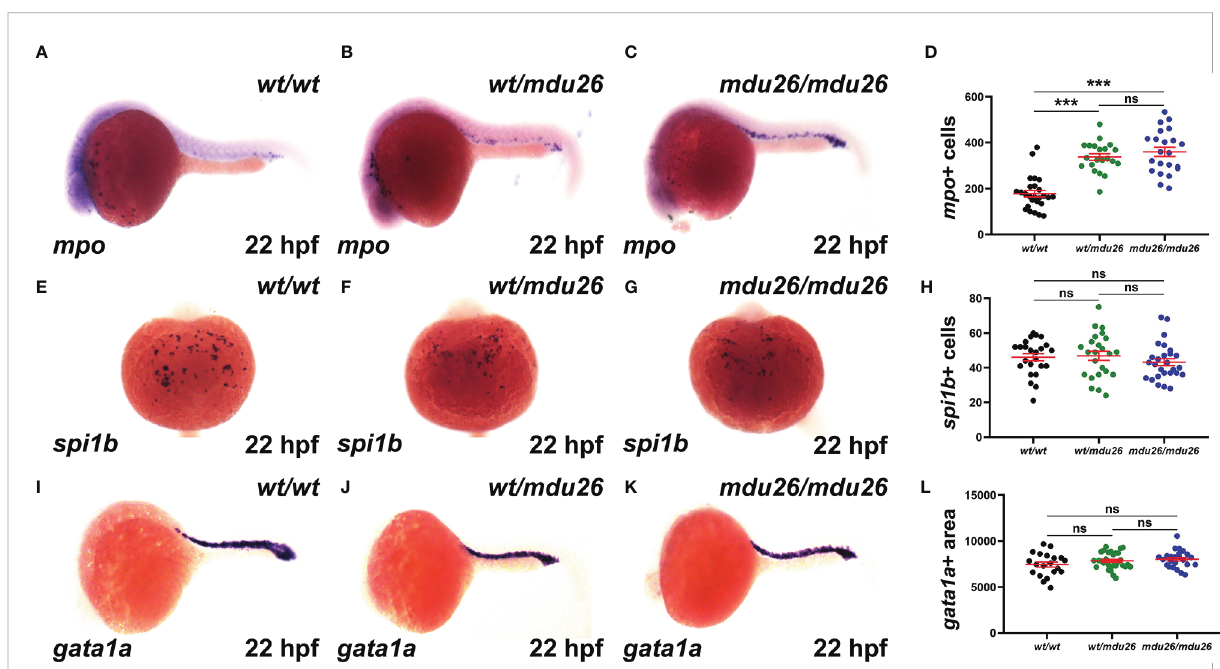
FIGURE 2 Effect of G-CSFR truncation mutation on primitive hematopoiesis. Wild-type ( wt/wt ), heterozygous ( wt/mdu26 ) and homozygous ( mdu26/ mdu26 ) mutant csf3r embryos were subjected to WISH at 22 hpf with mpo (A – C) , spi1b (E – G) and gata1a (I – K) , with representative images shown. Individual embryos were assessed for the number of mpo + (D) or spi1b + (H) cells or the area of gata1a (L) staining, with mean and SEM in red and level of statistical signi fi cance indicated (***: p < 0.001, ns: not signi fi cant;